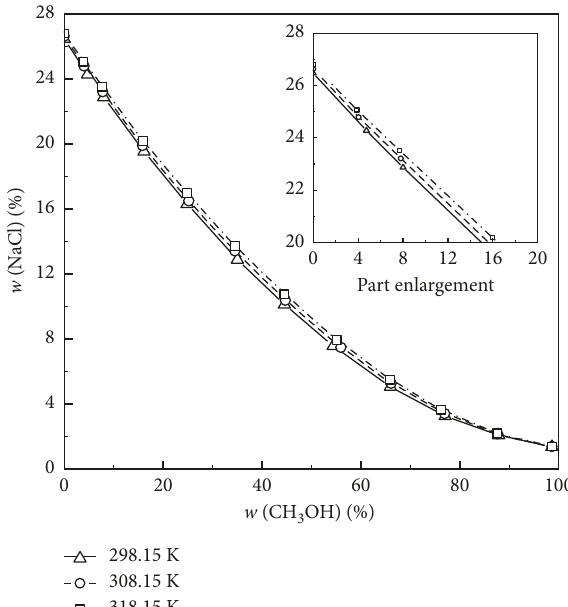
Figure 5: Comparison of the sodium chloride content of the ternary system(NaCl + CH experimental point at 298.15 K; (—), solubility curve at 298.15K; ( ○ ), experimental point at 308.15 K; (- -), solubility curve at 308.15K; ( □ ), experimental point at 318.15K; (- · -), solubility curve at